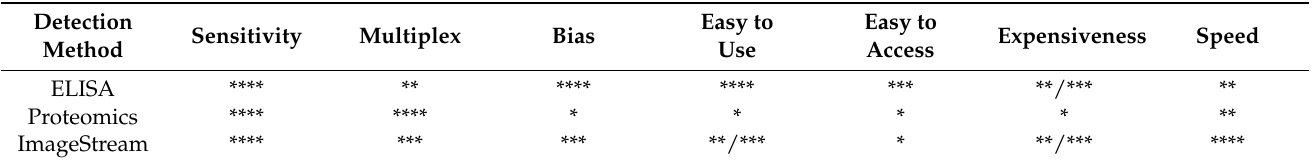
Table 2. Characterization of ELISA, Proteomics, and ImageStreamX for the analysis of circulating histones and histone complexes. The advantages and disadvantages of the indicated parameters are illustrated through an asterisk-based